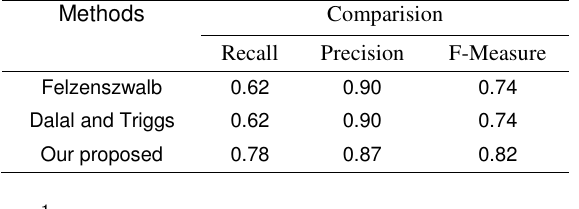
Figure 5 . Recall-precision curves (RPC) of PET sequence.